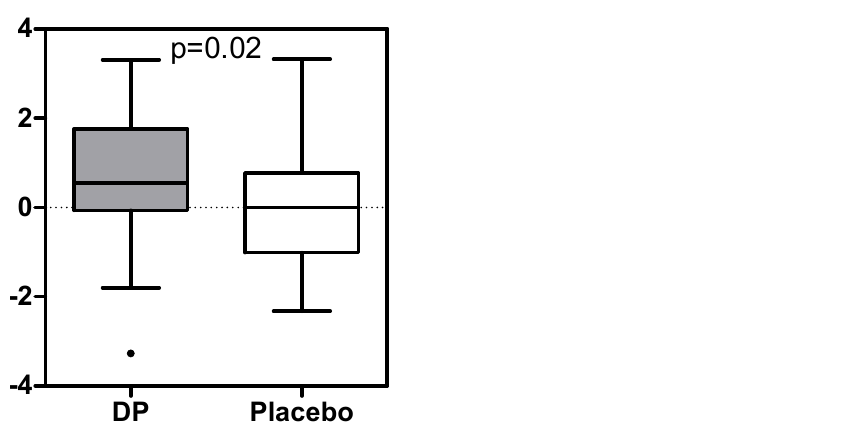
Figure 3. Bivariate analyses show an increase in Bifidobacterium over time (2log ratio of relative abundance at day 21 and day 0) for the DP and no change for placebo group (ITT) ( p = 0.02). Boxplots are displayed as Tukey whiskers. DP: Dairy-based test product. Placebo: skimmed milk.